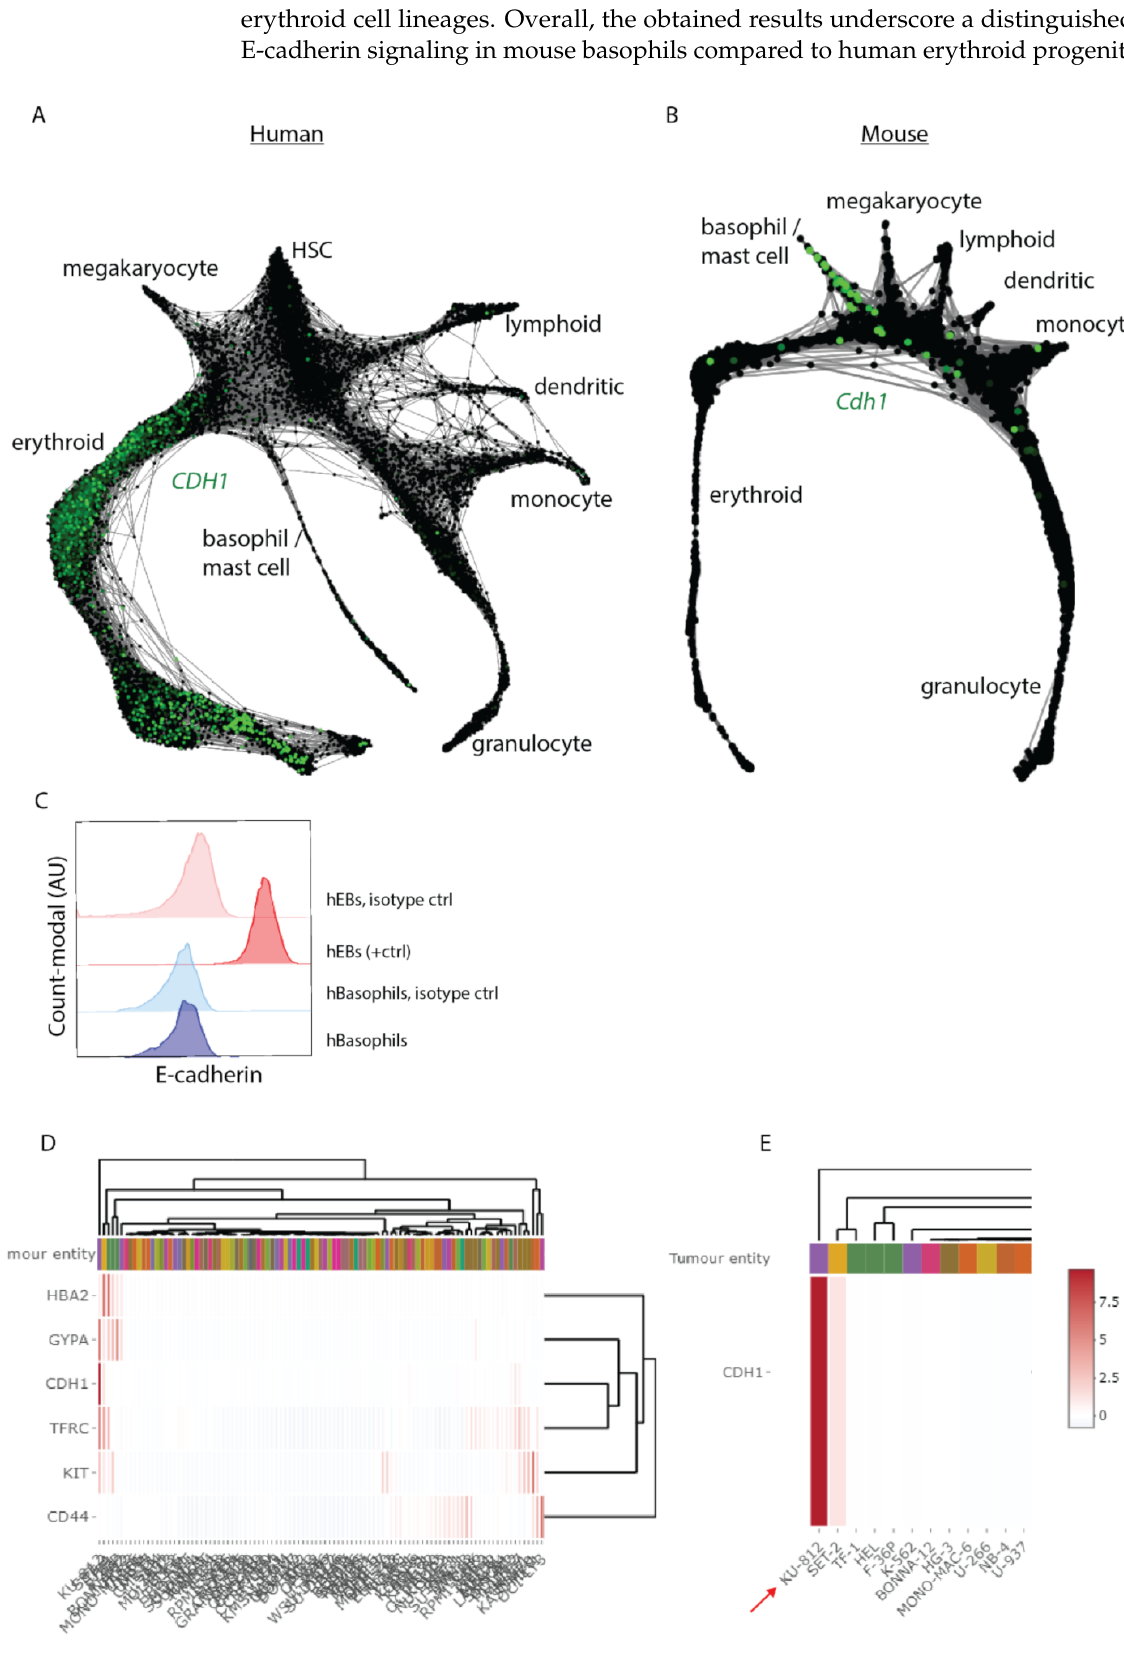
Figure 4. Cdh1 mRNA expression is not conserved between human and mouse hematopoiesis within the erythroid and basophil lineages. ( A ) A previously published high-resolution single-cell